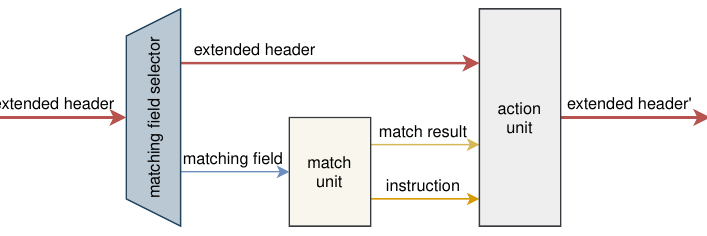
Figure 3. The architecture of the programmable processing unit.